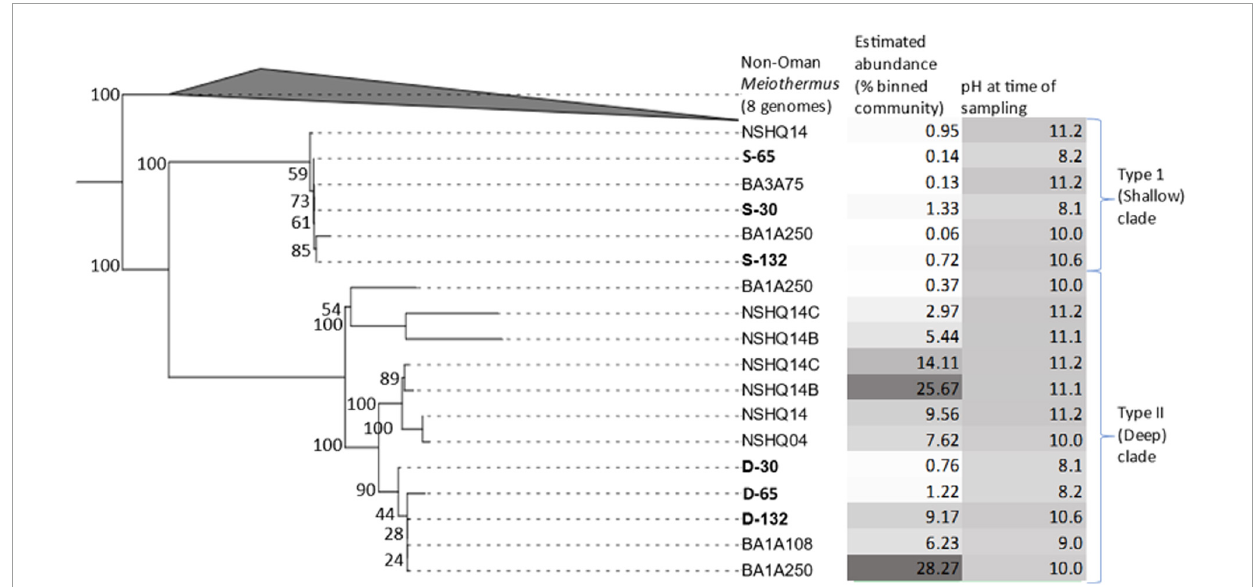
FIGURE2 Maximum-likelihood phylogenomic reconstruction of a concatenation of 115 housekeeping genes from metagenome assembled genomes (MAGs) recovered from discrete depth intervals in wells BA1A (sampled with packer system), BA1A (sampled using niskin bottles), BA3A (sampled using niskin bottles), or from specified depths (open well pumping) in NSHQ14B (50 m) and NSHQ14C (85 m). Eight genomes of non-Oman Meiothermus served as the outgroup. For BA1A samples collected with the packer system, MAGs are labeled as belonging to the Type I surface phylogenetic clade (S) or the Type II deep phylogenetic clade (D) followed by the maximum depth interval (m) from where they were recovered (30, 65, 132). For BA1A and BA3A samples collected with niskin bottles, MAGs are labeled by well followed by depth of recovery. Only MAGs that were most closely related to Meiothermus were considered. MAGs obtained from discrete depth intervals isolated by packers in well BA1A that were used for further genomic analyses are in bold. Bootstrap scores are indicated at each node. The relative abundance of MAGs (% of mapped reads) and the pH of fluids at the time of sampling are indicated, with darker colors corresponding to higher values for both